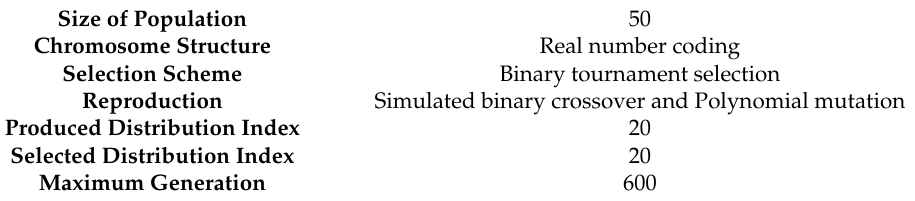
Table 12. Parameters of proposed NSGA–II algorithm for multi-objective optimization.